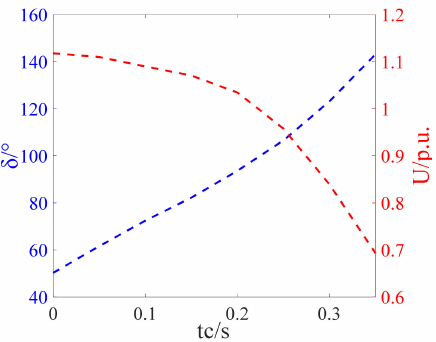
Figure 3. Simulation results of the receiving-end power